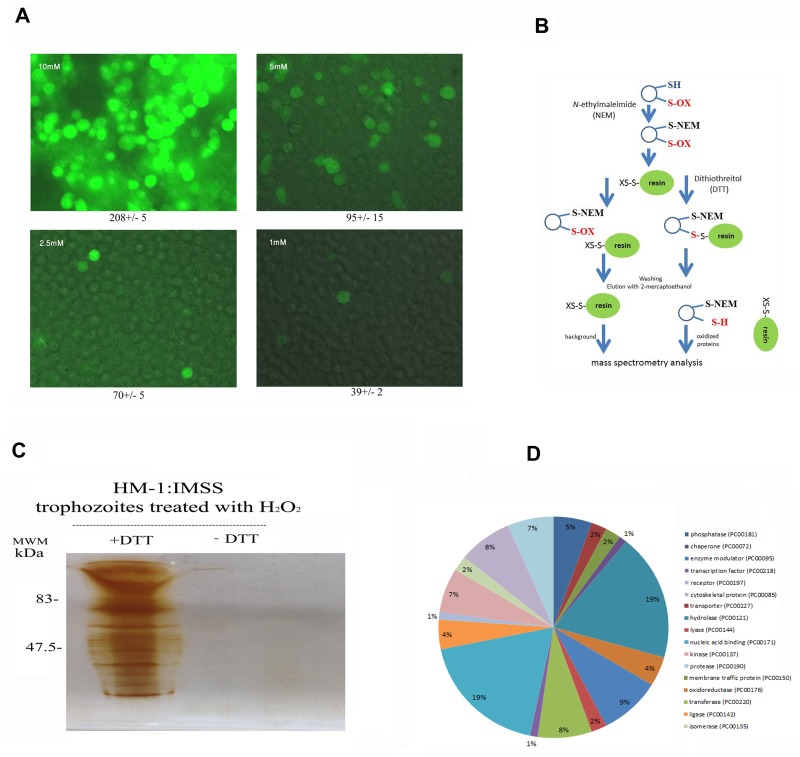
Analysis of oxidized proteins in E. histolytica after resin-assisted capture.A. Detection of intracellular ROS level. Control and oxidatively stressed trophozoites were incubated with 0.4 mM (final concentration) 2,7-dichlorofluorescein diacetate for 15 minutes in the dark and then examined by fluorescence microscopy. The number in the top left side of each picture indicates the concentration of H2O2. The number in the bottom of each picture indicates the mean fluorescence for 20 cells according to a measure performed by image J. B. Methodology of OX-RAC. The scheme has been adapted from [14]. C. Silver staining of oxidized proteins. E. histolytica trophozoites strain HM-1:IMSS were treated with H2O2 for 60 minutes at 37°C and a total protein lysate was prepared by lysing the H2O2-treated trophozoites with 1% Igepal (Sigma) in phosphate buffered saline. The oxidized proteins in the cell lysates were subjected to resin-assisted capture (RAC) in the presence of 10 mM DTT (+DTT) or the absence of DTT (–DTT). D. Functional categories of all oxidized proteins. Oxidized proteins in E. histolytica were classified according to the protein class they encode using PANTHER sequence classification tool.